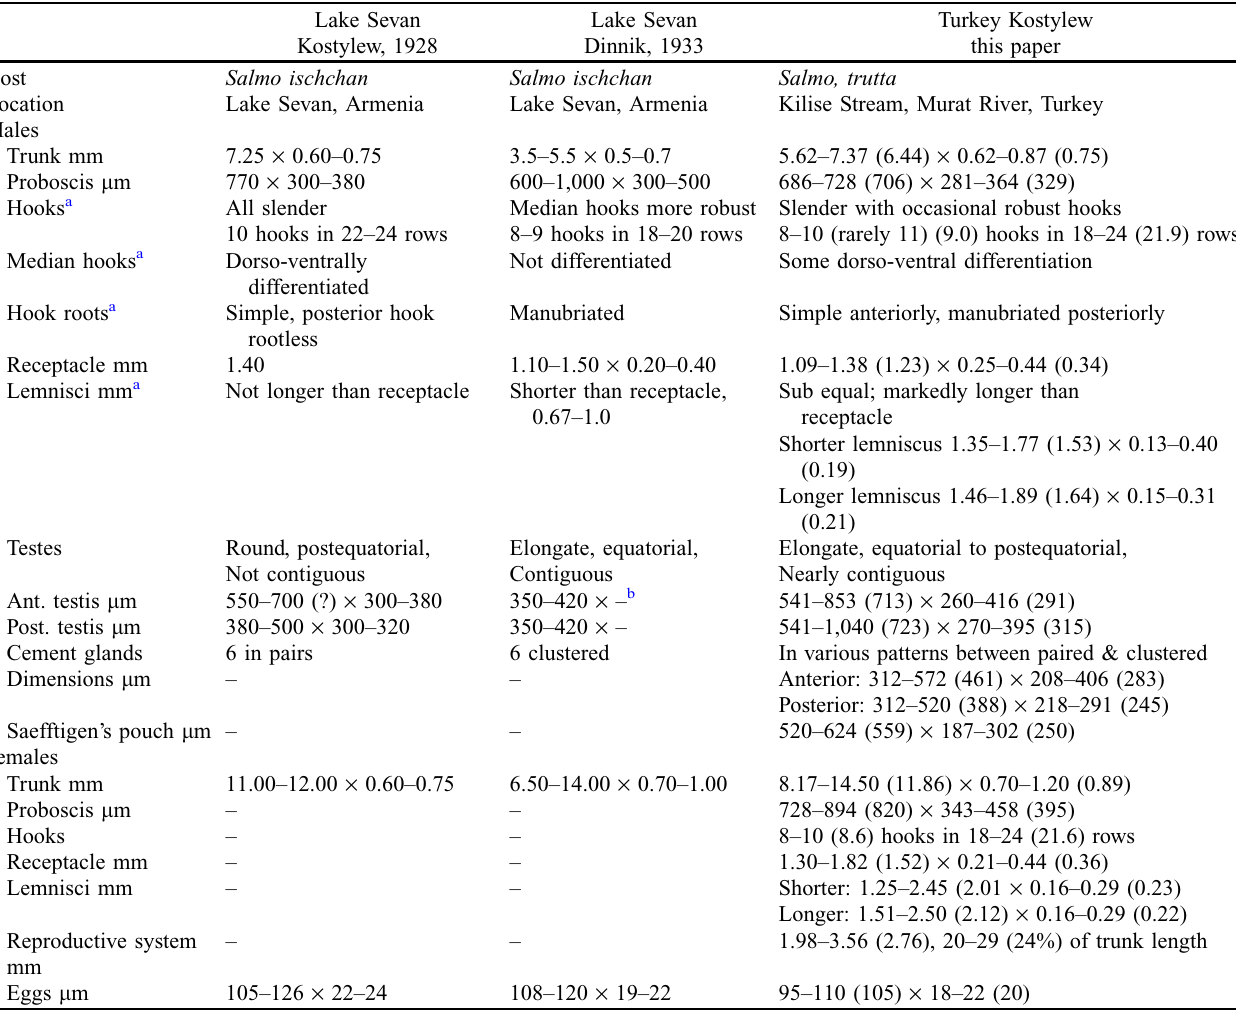
Table 1. A comparison between the three populations of Echinorhynchus baeri from Lake Sevan and